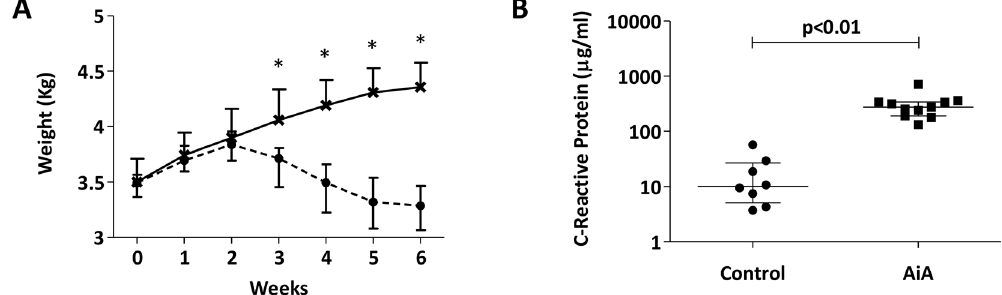
Figure 1. Effect of antigen-induced arthritis on weight and serum C-reactive protein (CRP). (A ) Changes in body weight in AiA and control rabbits across the study, asterisks ( * ) denote statistically significant differences between AiA and control groups, p < 0.05. ( B ) Serum CRP levels ( µ g/ml) at the end of the study. Data represent individual values; medians with IQRs are also indicated (n = 8–11 rabbits per